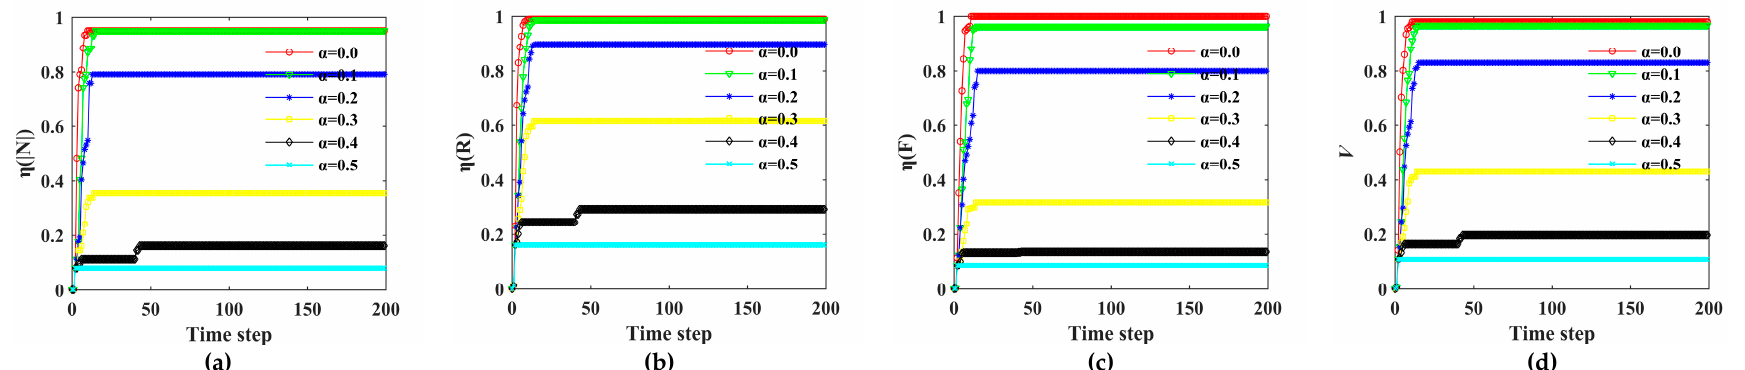
Figure 8. Cascading failures of Bus–Metro CBN under different rainstorm intensities. (a) – (c) show the loss ratio of node scale in the maximum connected subgraph, the network efficiency and the passenger flow with time under different rainstorm intensities, respectively. (d) shows the change of network vulnerability with time under different rainstorm intensities. Note: In these scenarios, α = 0.3, ε 1 = 0.2, ε 2 = 0.2, λ 1 = λ 2 = λ 3 = 1 .